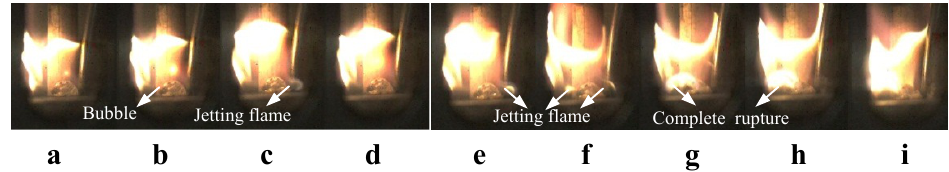
Figure 3. Picture series of burning gelled propellant droplet on the hot plate.